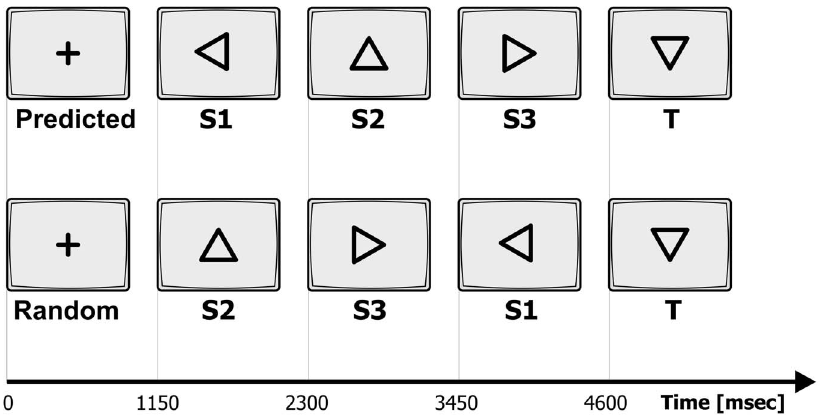
Figure. 1. Task timeline. Stimuli presented in the sessions. Sequences of standards S1, S2 and S3 with a predicted sequence (top) and in randomized order (bottom) preceding the target (T). The predictive sequence is always S1 followed by S2 and then S3 (n-1). Inter-trial intervals, including duration of stimulus presentation (150 ms) are displayed. Each block consisted of 6 different randomized sequences of standards (3–8 standards long) preceding the target; and 6 sequences of standards (3–8 standards long) with the predictive sequence preceding the target in each.